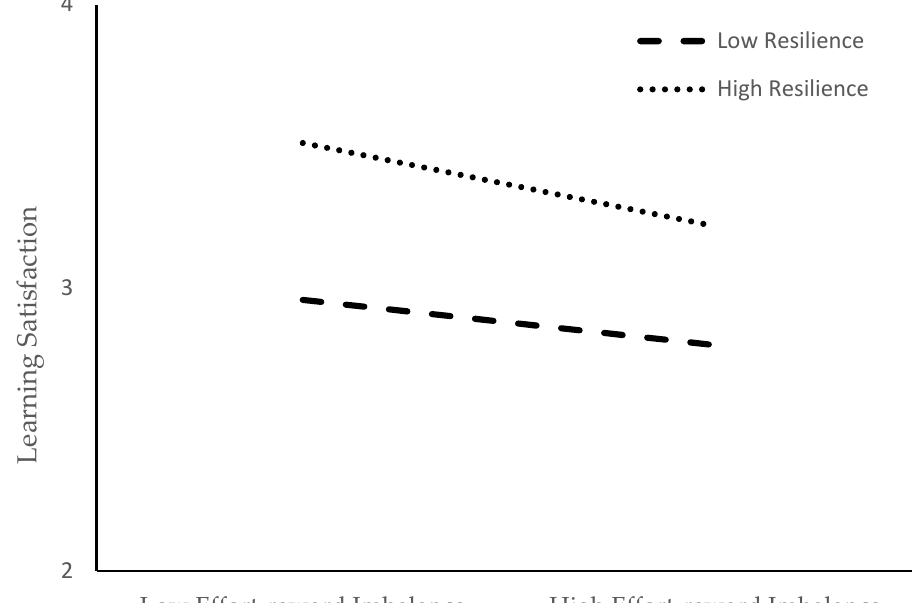
Figure 3. Moderating effect of resilience between effort-reward imbalance and learning satisfaction.